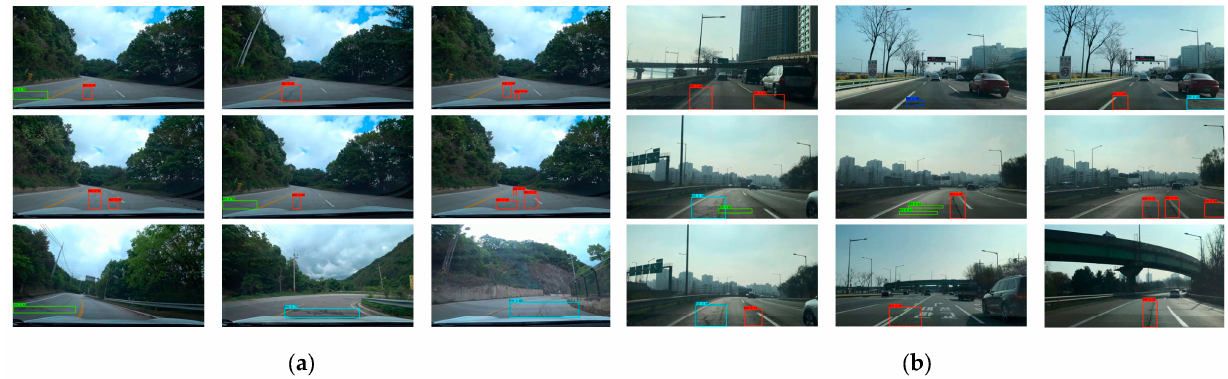
Figure 14. Examples of real-time detection of the proposed method cover ( a ) suburban and ( b ) urban road conditions in Korea.